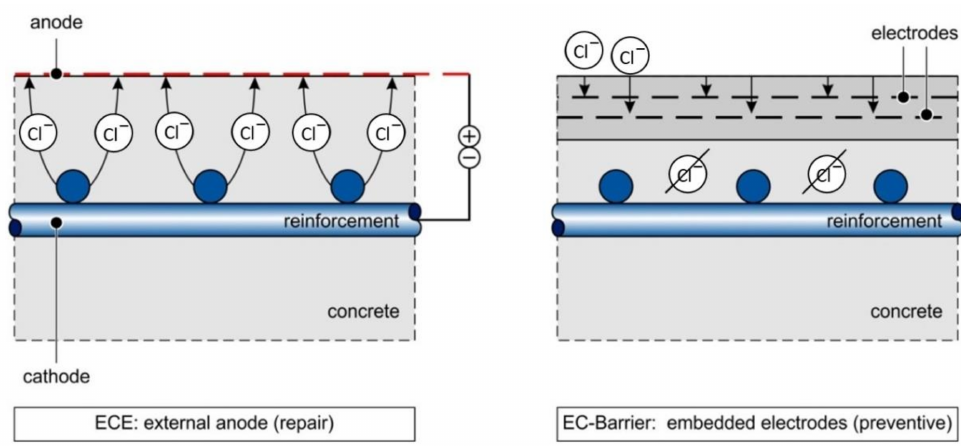
Figure 1. Comparison ECE vs.